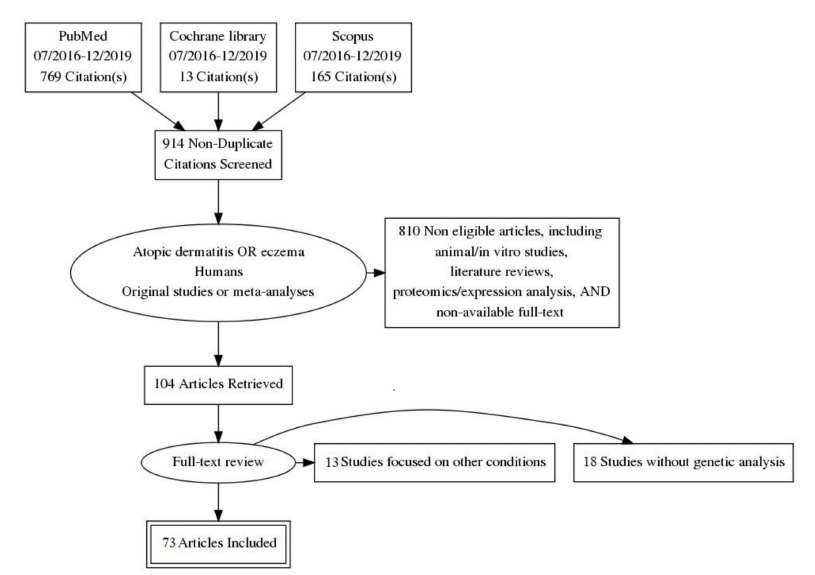
Figure 1. The flow diagram depicts the flow of information through the di ff erent phases of the systematic review. It maps out the number of records identified, included and excluded, and the reasons for